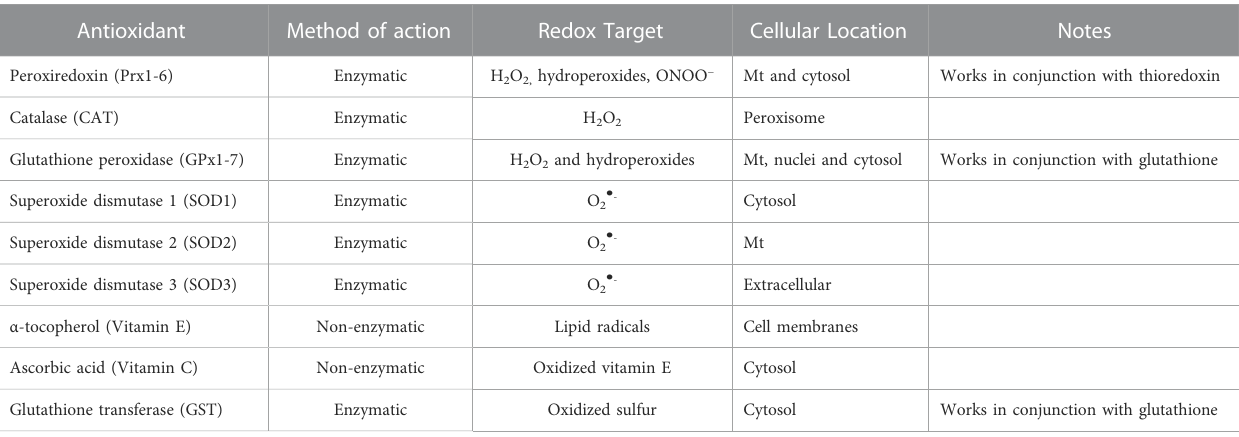
TABLE 1 Antioxidant enzymes and redox